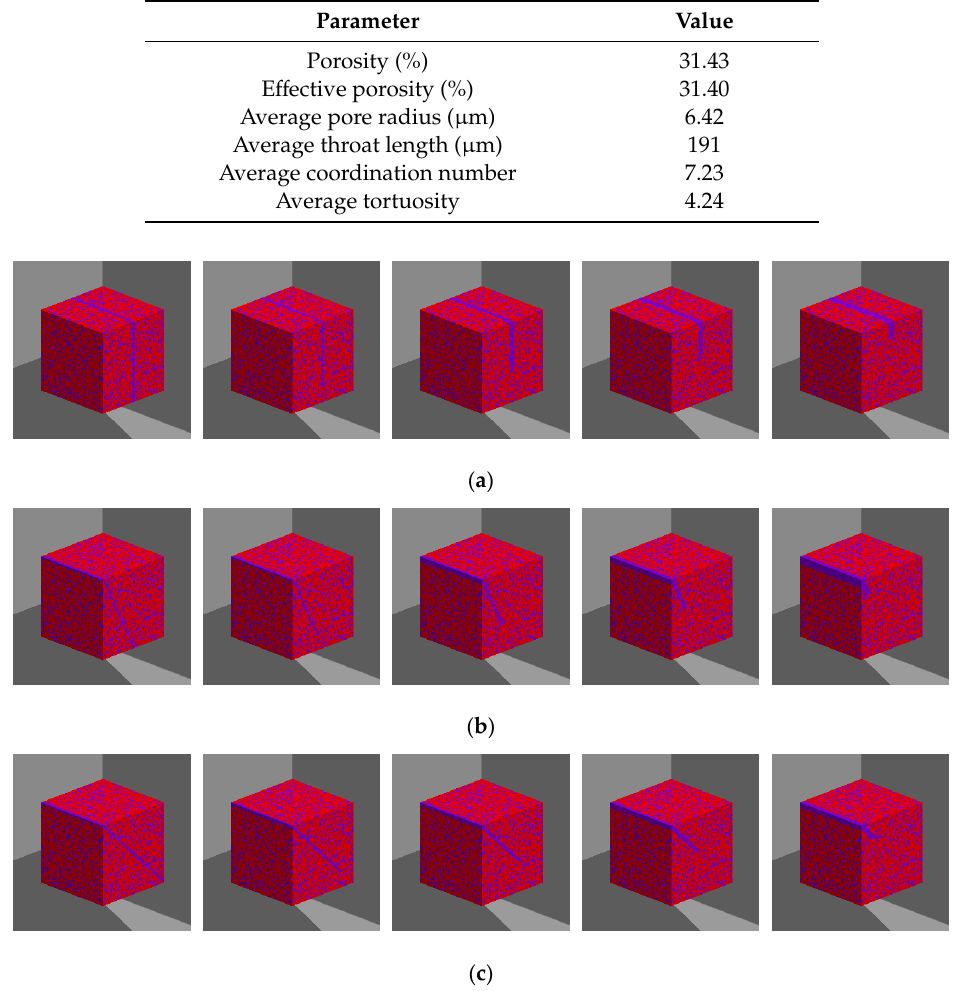
Figure 2. The extracted digital rock and the temperature distribution along three orthogonal heat flux directions: ( a ) The extracted digital rock of which the pore space is blue and the matrix is red. ( b ) The xy plane slice of extracted digital rock. The temperature distribution in ( c ) the xy plane with conduction along the X direction, ( d ) the xy plane with conduction along the Y direction, and ( e ) the xz plane with conduction along the Z direction. Table 1. The parameters of the extracted digital rock.